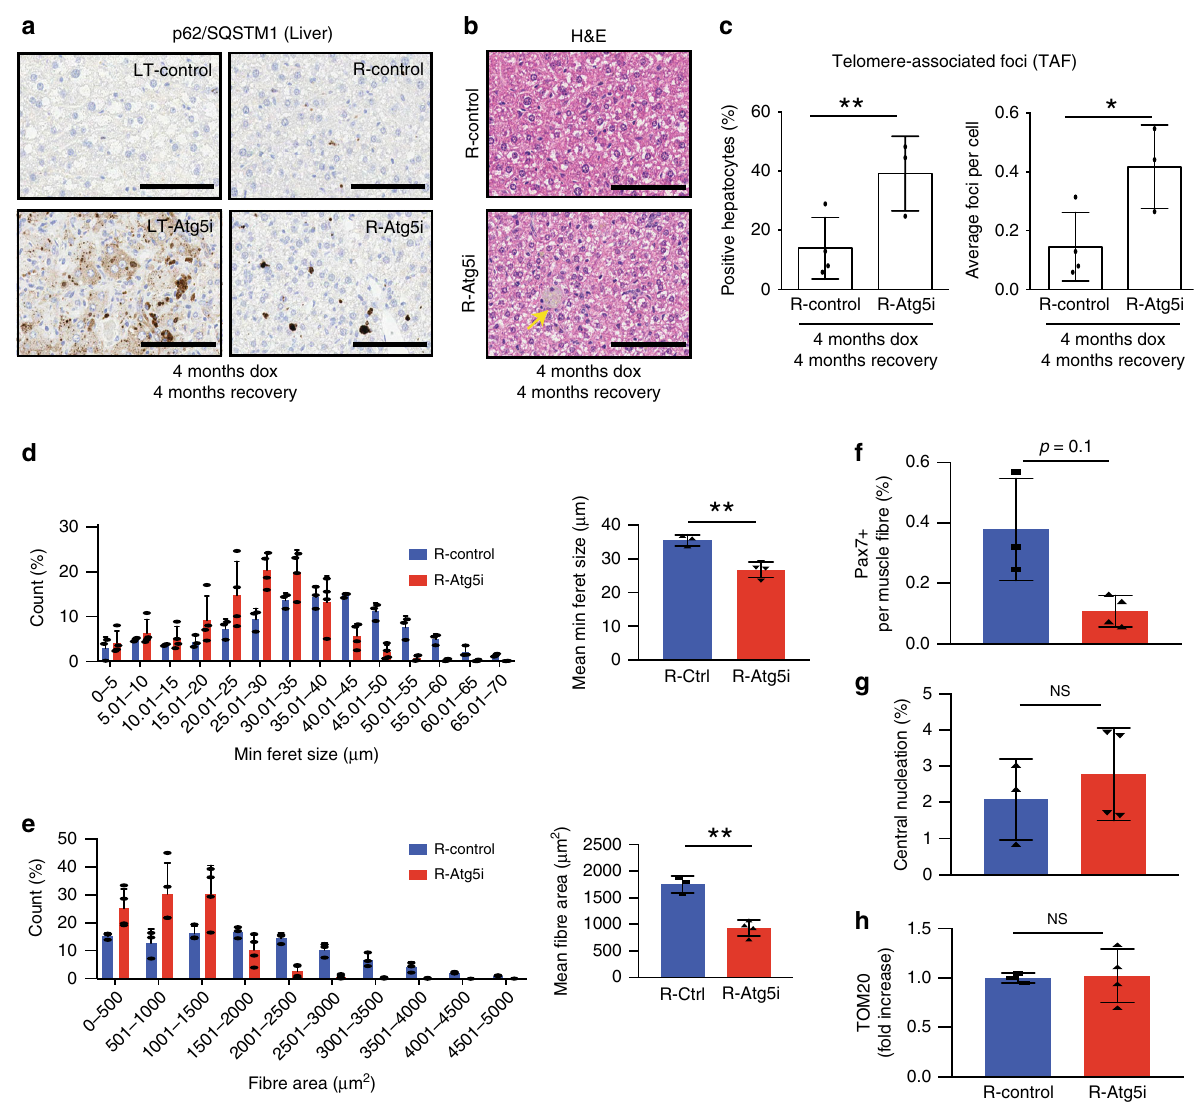
Fig. 5 Restoration of autophagy does not reverse all markers of aging. a p62/Sqstm1 staining of R-Atg5i liver highlights the incomplete removal of aggregates 4 months after autophagy restoration. Scale bars, 100 μ m. b The same livers have a higher incidence of age associated pigmentation in comparison with age-matched control mice. (yellow arrow). c TAF frequency and abundance also remains elevated in R-Atg5i mice (unpaired two-tailed t test; n = 4 R-Ctrl and 3 R-Atg5i). Skeletal muscle analysis from 4 months dox treated and 2 months restored R-Atg5i mice. R-Atg5i muscle fi bres continue to display signi fi cant alterations in minimum feret size ( d ) ( n = 3 R-Ctrl and 4 R-Atg5i, Mann Whitney test) and cross-sectional area ( e ) ( n = 3 R-Ctrl and 4 R-Atg5i, Mann Whitney test). Whilst Pax7 nuclear positivity per fi bre still displays no evidence of recovery ( f ), both central nucleation ( g ) and positivity for the mitochondrial marker Tom20 ( h ) exhibit levels similar to R-Ctrl mice. ( f – h , unpaired two-tailed Welches t test; n = 3 R-Ctrl and 4 R-Atg5i). Error bars indicate standard deviations. * p < 0.05; ** p < 0.01, *** p <